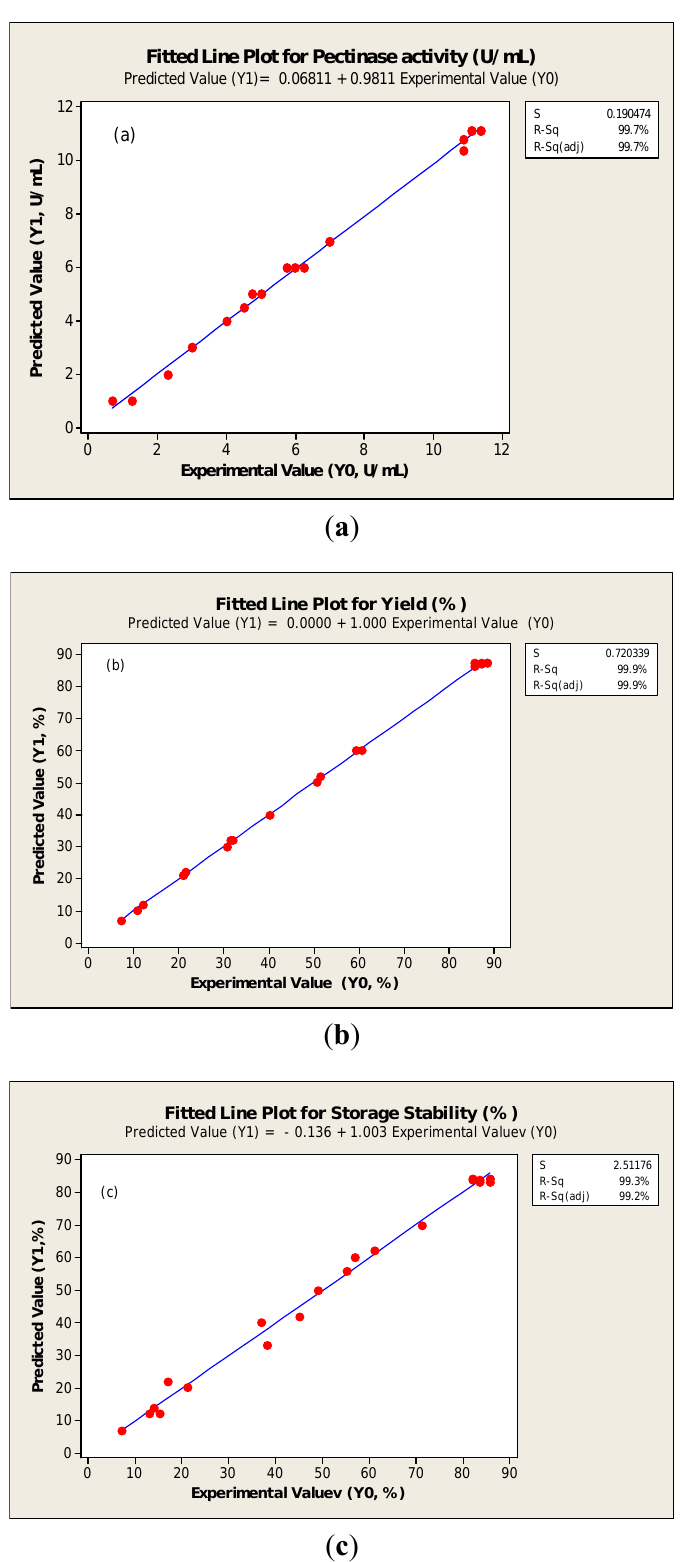
Figure 2. Fitted line plot indicating the closeness between predicted values (Y1) and experimental value (Y0) for pectinase activity ( a ), yield ( b ) and storage stability ( c